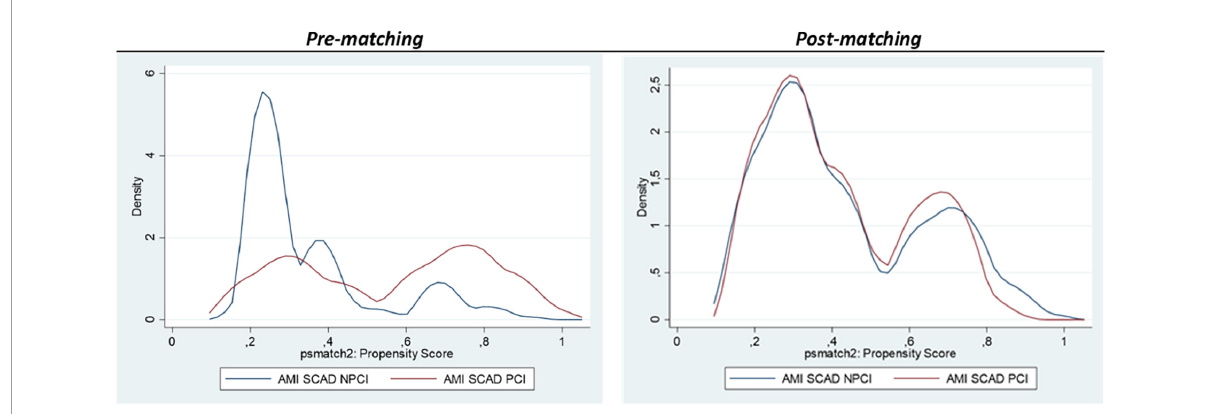
FIGURE4 Kernel Density plots representing the pre- and post- matching. 30-days